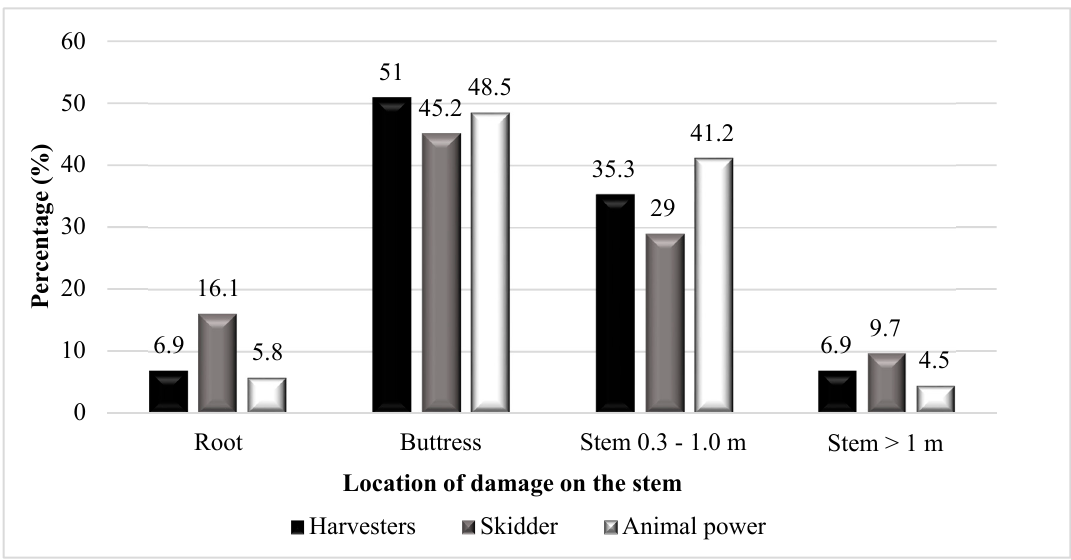
ff erent locations along the stem.